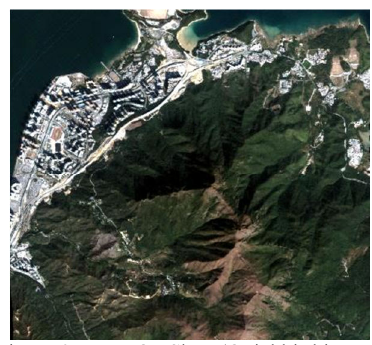
Figure 3. Ma On Shan (Quickbird